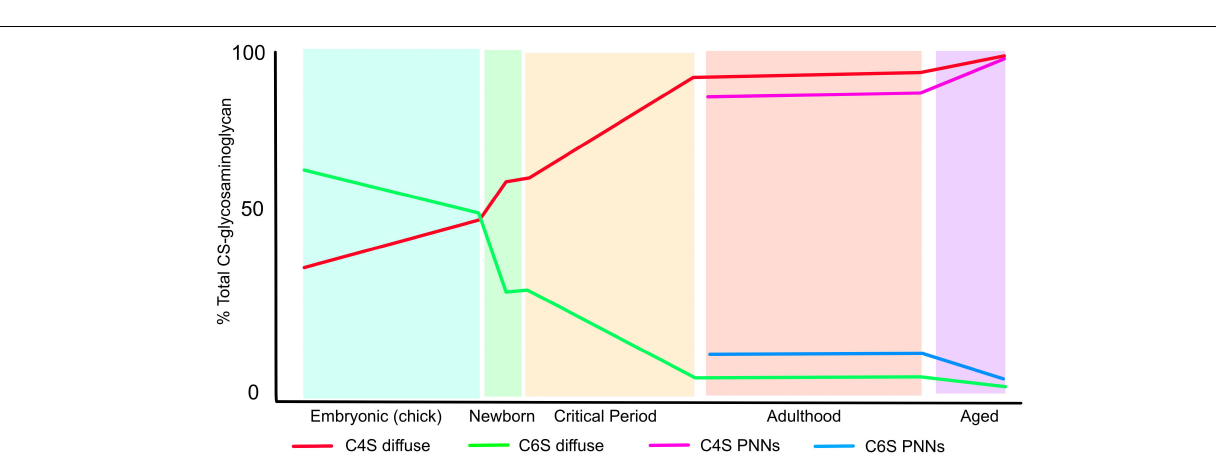
FIGURE 2 | The pattern of CS-GAG sulphation changes during the lifespan. The graph shows the percentage of CS-GAG decorated with C4S and C6S during development, postnatal, critical periods for plasticity, adulthood and ageing. The figures for embryonic development come from chick embryos brains, the rest from rat brains (see text for references). The figure shows the progressive loss of C6S and increase in C4S during the lifetime. The sulphation pattern of PNNs differs from that of the diffuse